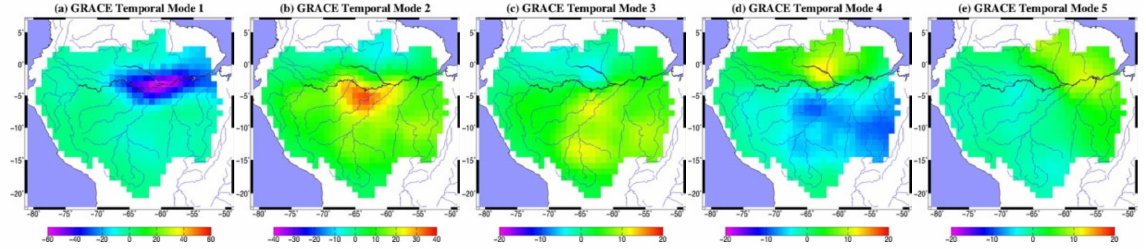
Figure A5. Five leading GRACE spatial patterns as identified using